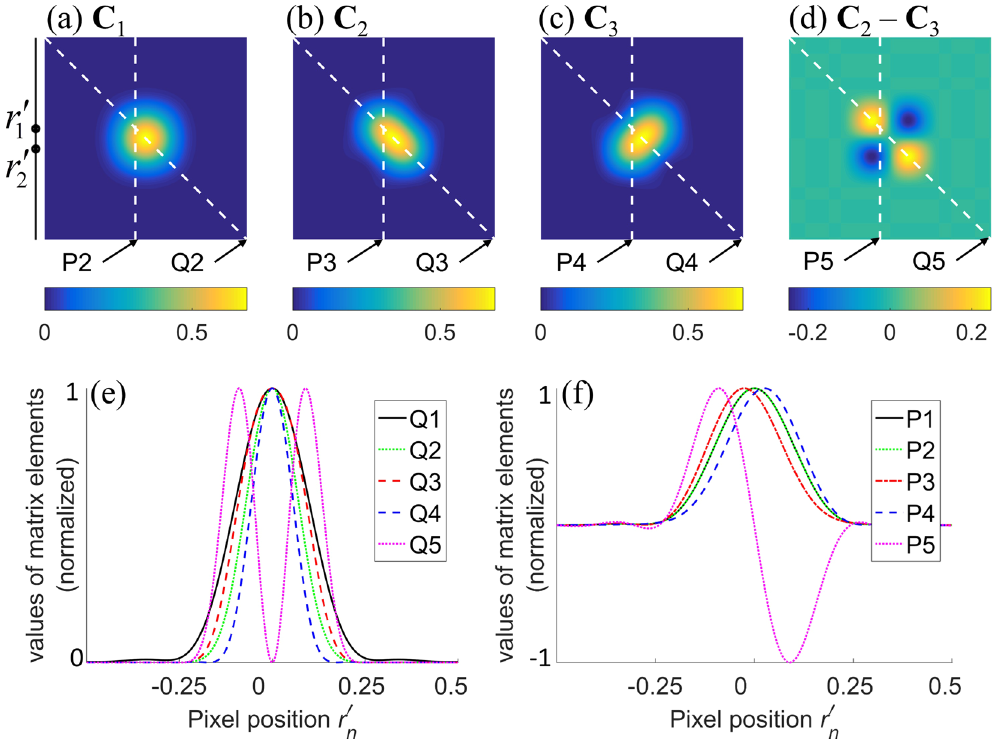
Figure 2. Matrices C 1 , C 2 , C 3 , ( C 2 − C 3 ) for example 1 are shown in ( a – d ). The distance between the emitters is 100 nm. The plots for n ′ = n are shown in ( e ) and the plots for ′ = − r 50 nm are shown in ( f ). Plots Q1 and P1 in n ( e , f ) are both equal to  G . All the plots in ( e , f ) are normalized by their maximum amplitudes.